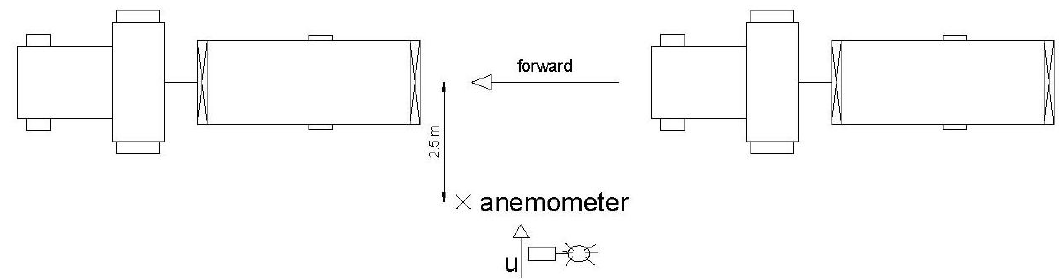
Figure 5. Outline of the measurement point of the dynamic analysis.